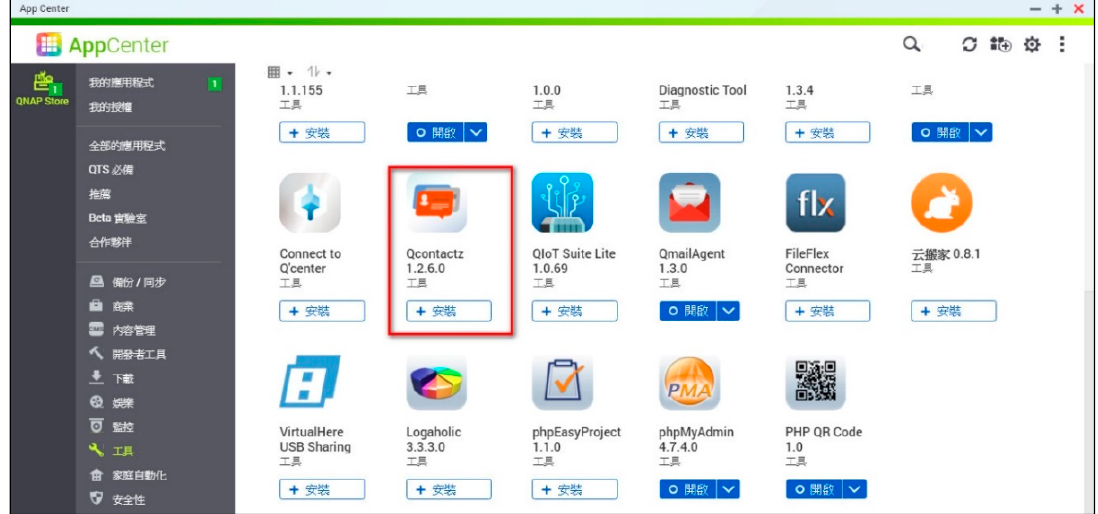
Arts 2018 , 7 , x FOR PEER REVIEW